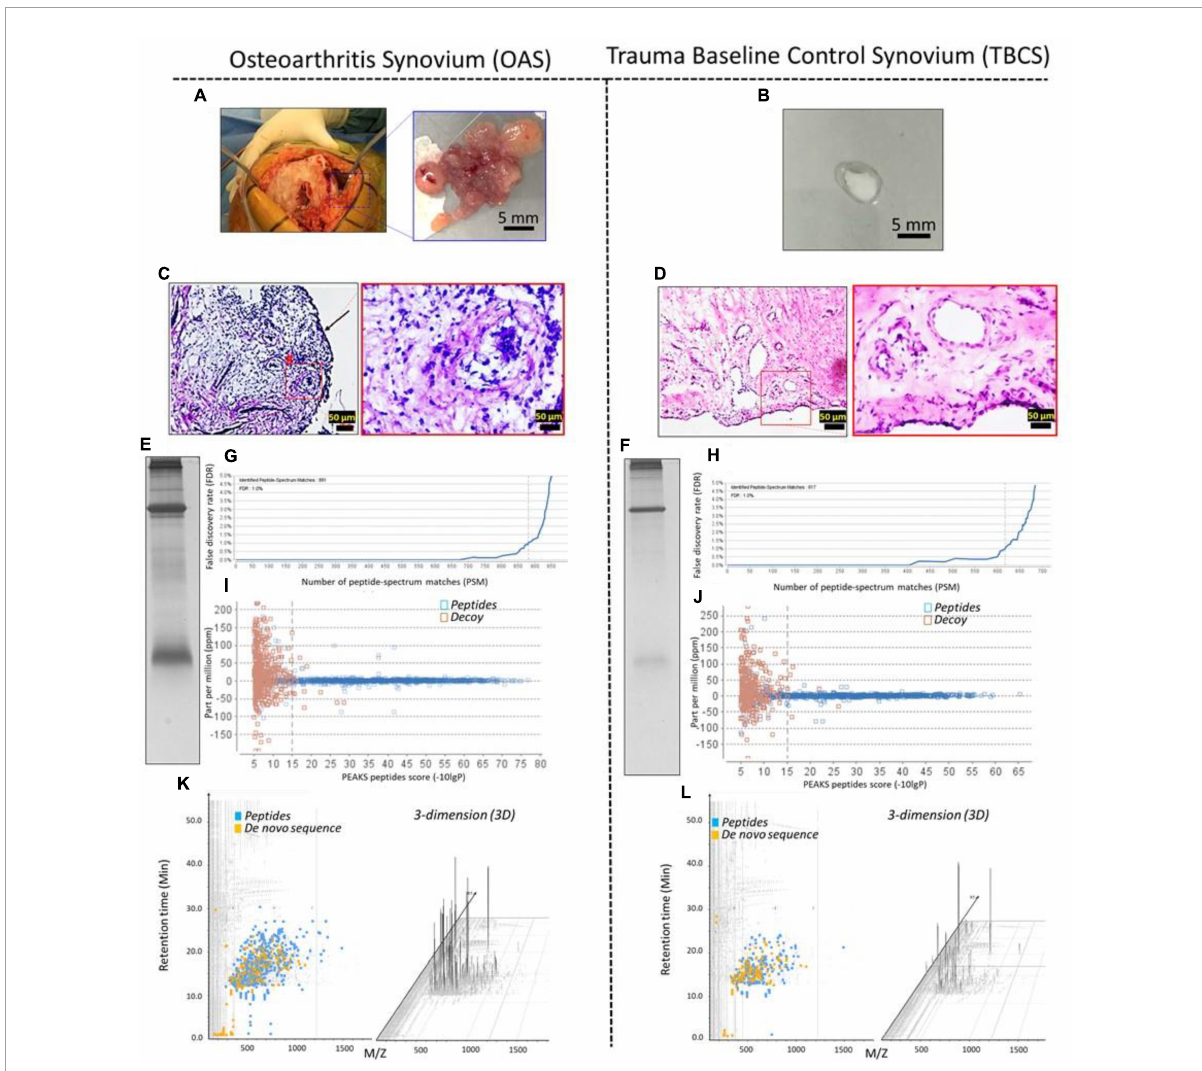
FIGURE1 The profile of OA synovium (OAS) and trauma baseline control synovium (TBCS). (A) Synovium from the end-stage knee OA patient underwent knee arthroplasty. (B) Synovium from the sports trauma patient underwent arthroscopic surgery for anterior cruciate ligament (ACL) repair. (C,D) H&E stained microphotographs. (E,F) SDS-PAGE protein bands of pooled OAS or TBCS. (G,H) False discovery rate (FDR) curve of peptides matched with the corresponding ESI-LCMS/MS QTOF spectra of peptides. (I,J) Peptide spectrum matches (PSMs) score distribution of target (blue square—OAS or TBCS) and decoy (amber square). (K,L) LCMS distribution profile and 3D intensity peaks of peptide and de novo